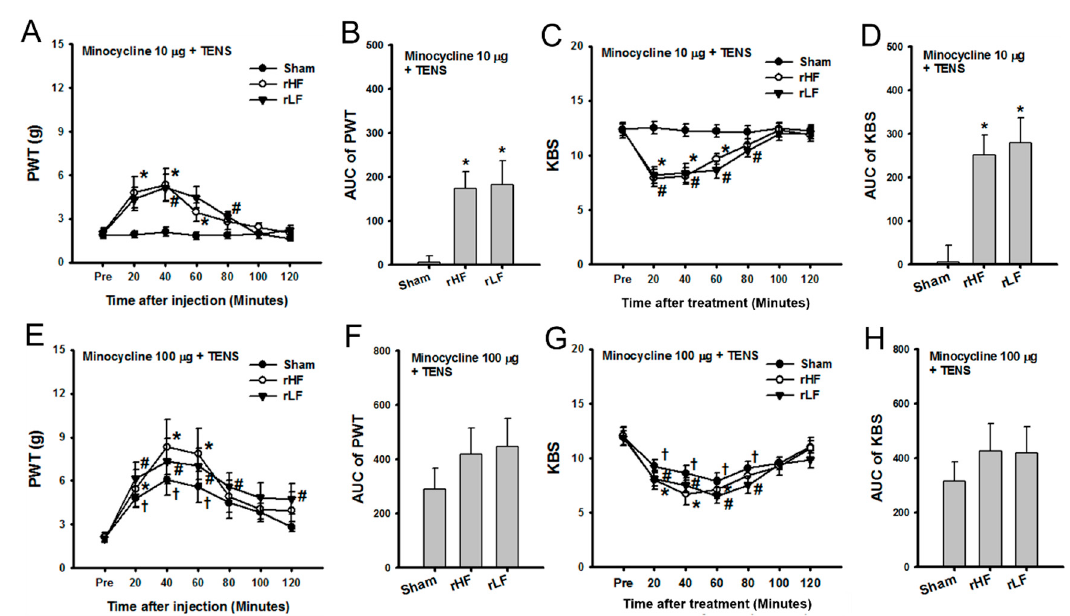
Figure 5. The e ff ects of transcutaneous electric nerve stimulation (TENS) with minocycline treatment on osteoarthritic (OA) pain in TENS-tolerant rats ( A ) The paw withdrawal threshold (PWT) in TENS-tolerant rats significantly changed after TENS with minocycline (10 µ g) treatment. The PWT significantly increased from 20 min to 60 min after high-frequency (HF) TENS with minocycline and 40–80 min after low-frequency (LF) TENS with minocycline compared with that before TENS with minocycline in TENS-tolerant rats. ( B ) After treatment, both the HF and LF TENS groups showed a significant increase in the overall e ff ect on mechanical hypersensitivity of the hind paw compared with the sham TENS group. ( C ) The knee-bend scores (KBS) in TENS-tolerant rats significantly changed following TENS with minocycline treatment. The KBS significantly decreased from 20 min to 60 min after HF TENS with minocycline treatment and from 20 min to 80 min after LF TENS with minocycline compared with that before TENS with minocycline in TENS-tolerant rats. ( D ) After treatment, both the HF and LF TENS groups showed a significant increase in the overall e ff ect on knee joint pain compared with the sham TENS group. ( E ) The PWT in TENS-tolerant rats significantly changed after TENS with minocycline (100 µ g) treatment. The PWT significantly increased from 20 min to 60 min after HF TENS with minocycline and from 20 min to 80–120 min after LF TENS with minocycline compared with that before TENS with minocycline in TENS-tolerant rats. In addition, sham TENS with minocycline treatment significant increased the PWT from 20 min to 60 min. ( F ) After treatment, the HF and LF TENS groups did not show a significantly increase in the overall e ff ect on mechanical hypersensitivity following OA compared with the sham TENS group. ( G ) The KBS in TENS-tolerant rats significantly changed following TENS with minocycline treatment. The KBS significantly decreased from 20 min to 60 min after HF TENS with minocycline treatment and from 20 min to 80 min after LF TENS with minocycline compared with that before TENS with minocycline in TENS-tolerant rats. Furthermore, sham TENS with minocycline treatment significantly decreased knee joint pain from 20 min to 80 min after treatment. ( H ) After treatment, the HF and LF TENS groups did not show a significant decrease in the overall e ff ect on OA knee pain compared with the sham TENS group. ( A , C , E , G ) Asterisks (*) indicate values significantly di ff erent from the value before intervention in the HF TENS group. Number signs (#) indicate the significant changes in the values compared with the value before intervention in the LF TENS group. Dagger ( † ) signs indicate significant changes in the values compared with the value before intervention in the sham TENS group. ( B , D ) Asterisks (*) indicate values significantly di ff erent from the AUC in the sham TENS